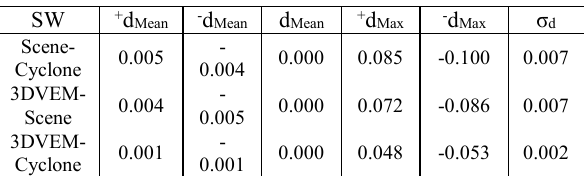
Table 2. Comparison between the different results of the deviations mesh-mesh (in m)